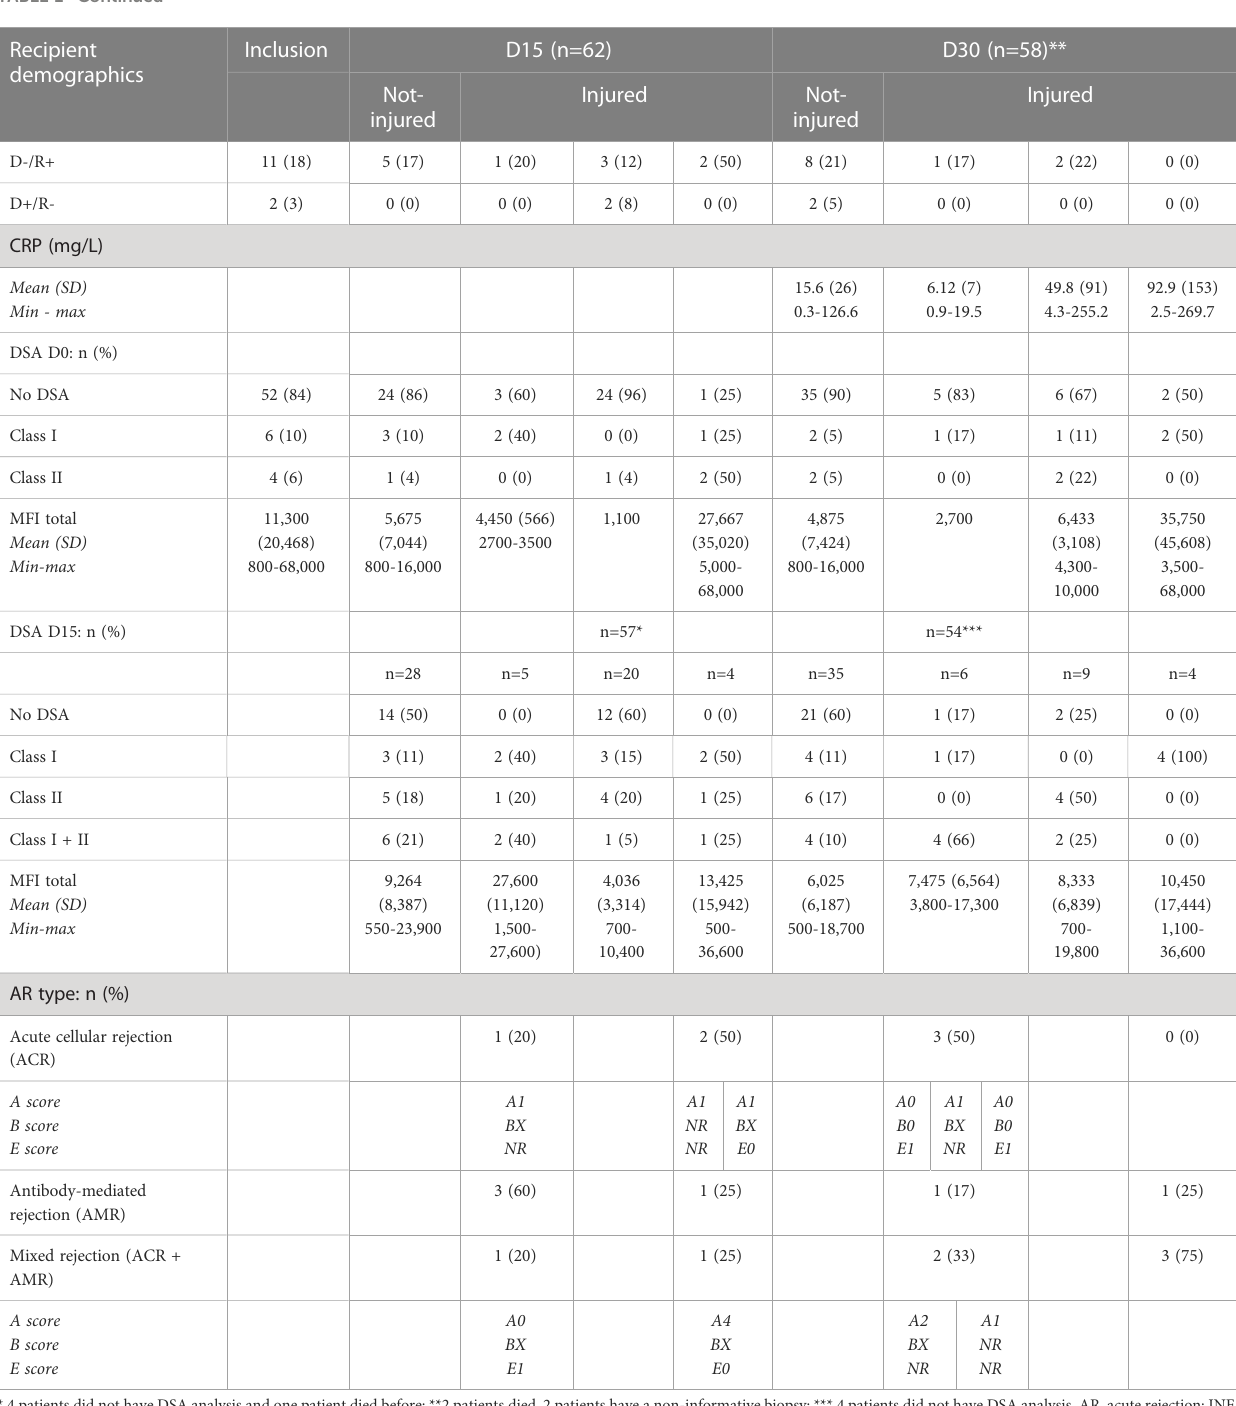
tended to correlate with small cfDNA sizes, 80-120 bp (p=0.010). At D30, the proportion of cfDNAs for sizes 80 to 120 bp correlated with INF, allowing us to differentiate between INF and NO-INF patients (p=0.005, Figure 5B). A ROC analysis considering the percentage of 80-120 bp cfDNA sizes associated with the INF group and NO-INF group indicated an AUC of 0.848 (p<0.0001), a NPV of 94.6% and a PPV of 61.1% for a threshold >3.7% (Figure 4B).